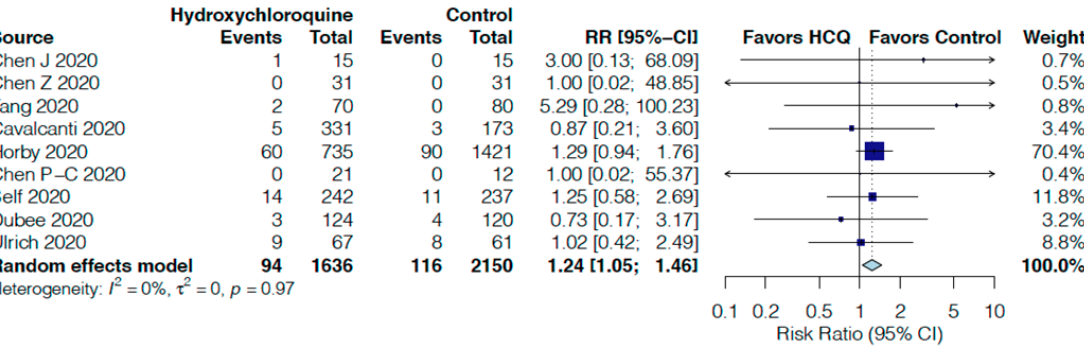
Figure 5. Effect of hydroxychloroquine on adverse events in hospitalized COVID-19 patients.